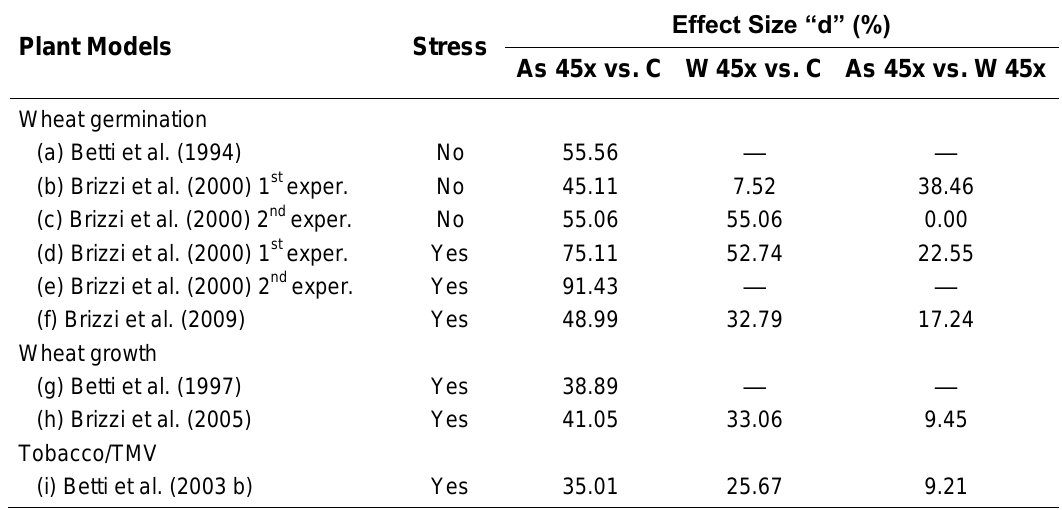
Effect S ize “d” Computed for the Three Plant